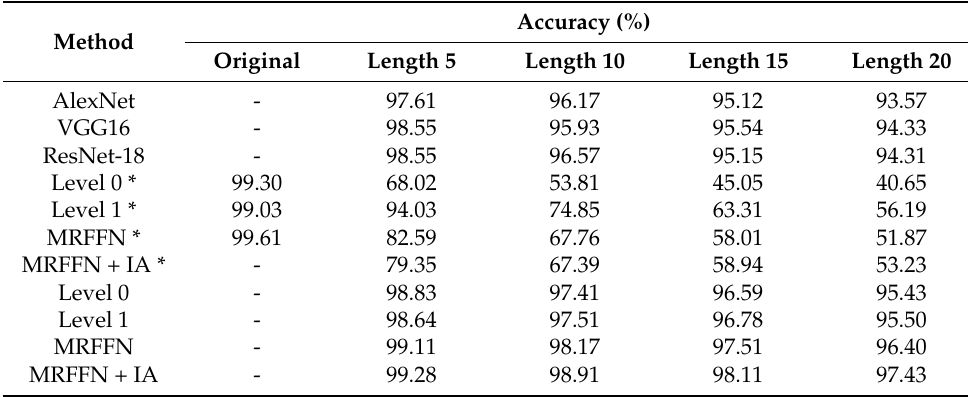
Table 6. The performance of the proposed method on motion